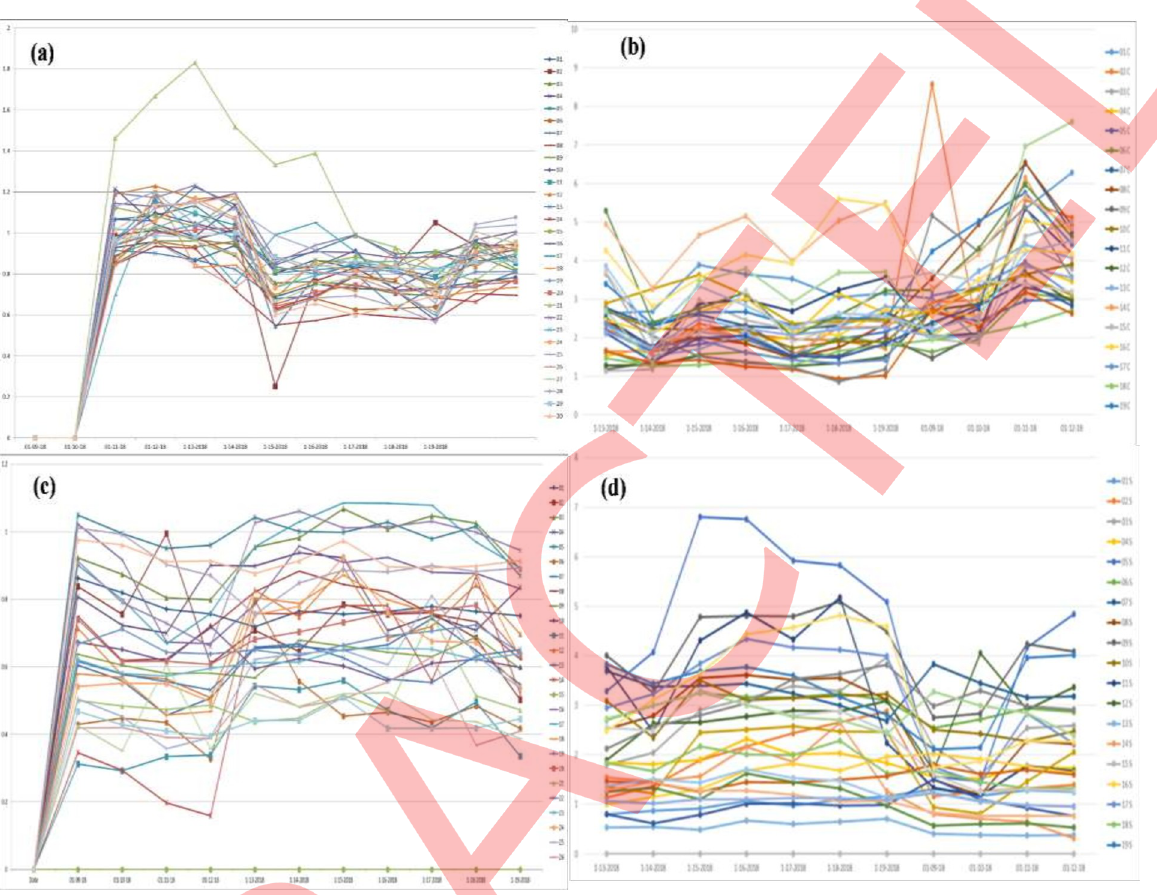
Fig 4. Illustration of genetic regulation of plant aspect ratio in control (a) and stressed pots (b), and genetic regulation of bi-convex hull ratio in control (c) and stressed pots (d).